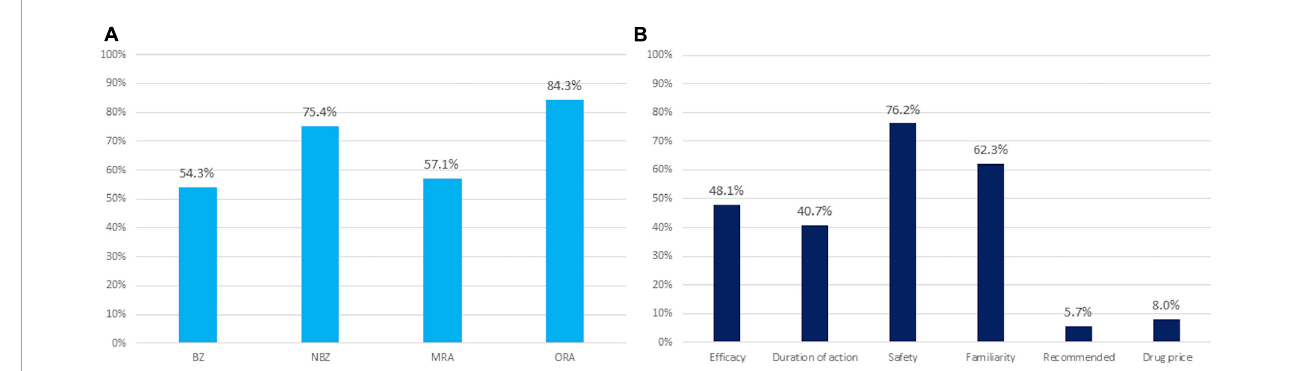
FIGURE1 Results of the survey. (A) Medications frequently used for insomnia. (B) Reasons for selecting medications frequently used for insomnia. Values are expressed as a percent. BZ, benzodiazepine; NBZ, non-benzodiazepine; MRA, melatonin receptor agonist; OR, odds ratio; ORA, orexin receptor